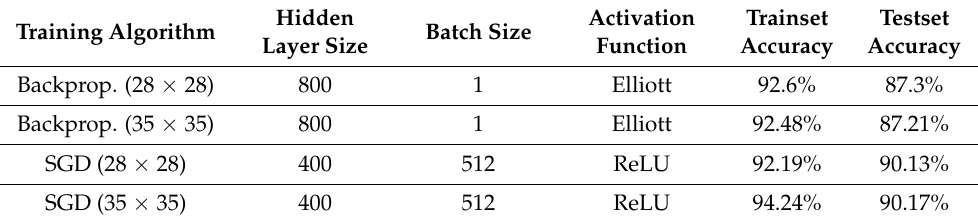
Table 5. Accuracy of the trainset–testset on 28 × 28 and 35 × 35